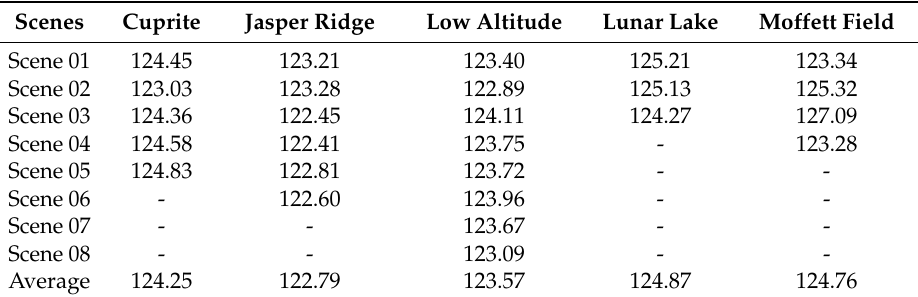
Table 4. Achieved results in terms of PSNR, by embedding w 2 (Dataset 1). Notice that by “/”, we